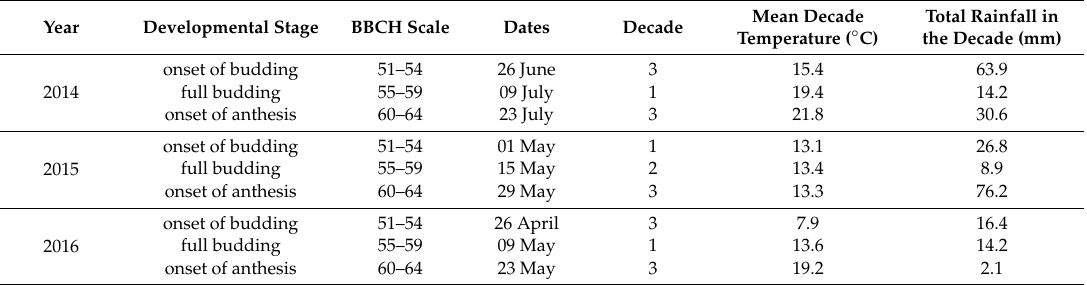
Table 1. Dates of the alfalfa development stages according to the BBCH scale, mean temperatures, and total rainfall in the respective decades.